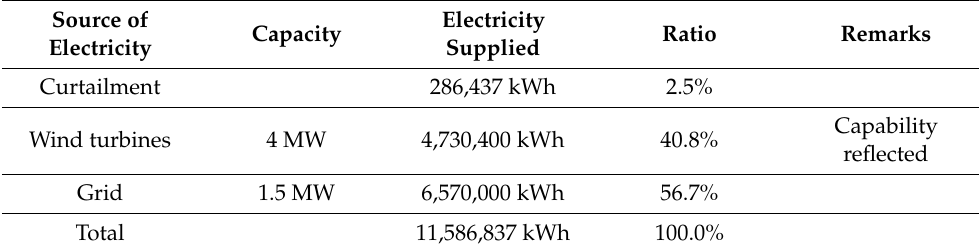
Table 13. The annual amount of electricity to be supplied to water electrolysis (Scenario I).